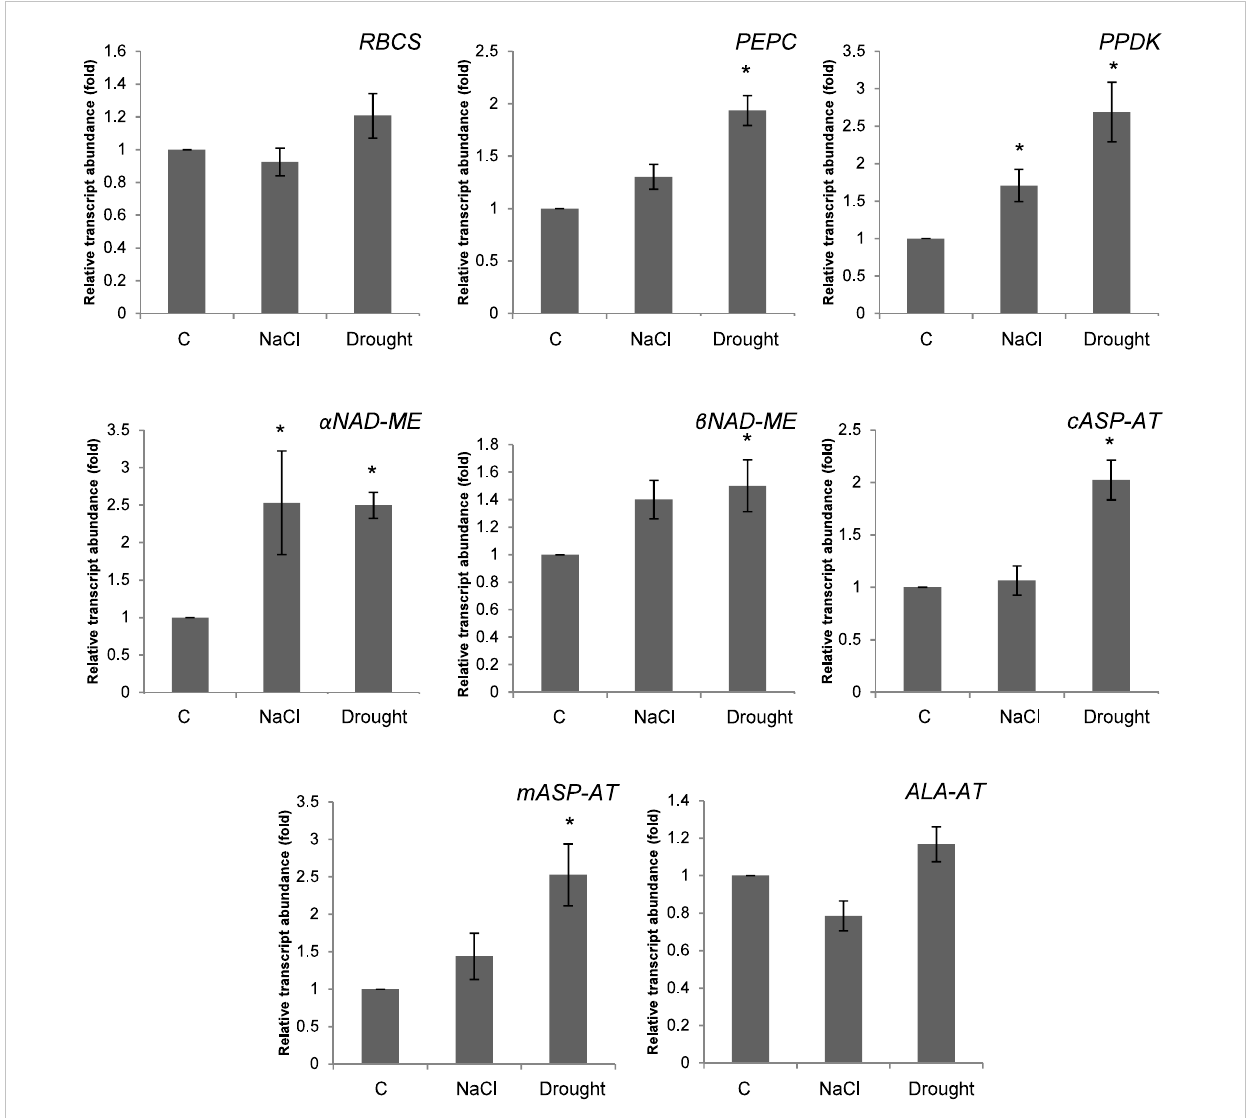
FIGURE 8 Expression of genes related to C 4 cycle in Bienertia sinuspersici treated with 400 mM NaCl or water withholding for 10 d. “ * ” indicates signi fi cant difference (p < 0.05) as compared to controls.